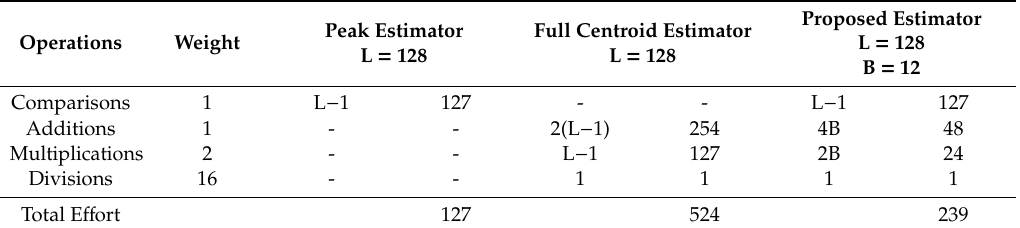
Table 2. Calculation power for the estimators.